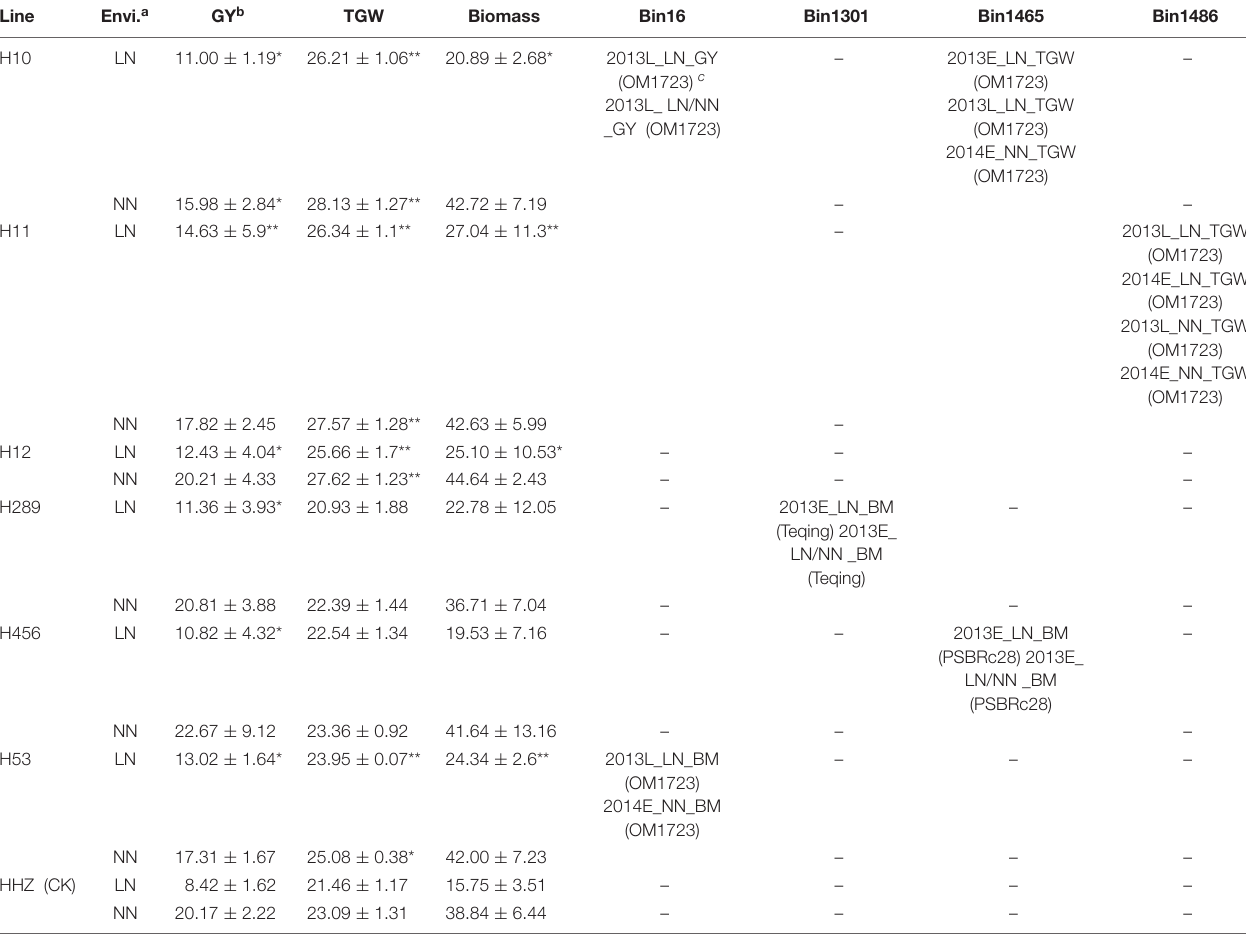
TABLE 4 | Phenotypic values and favorable introgressed alleles of the selected six superior lines.